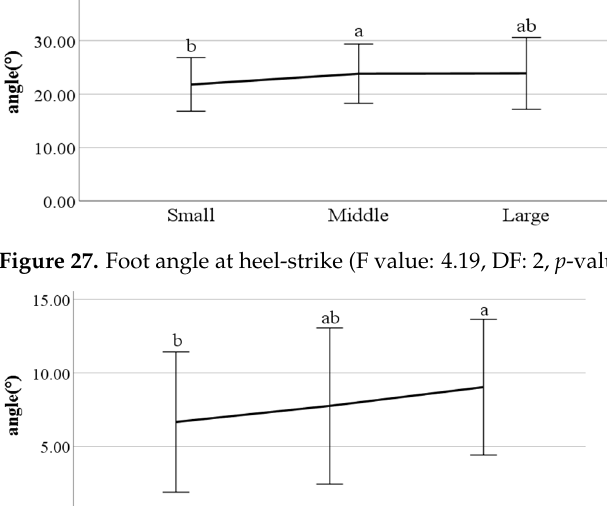
Figure 27. Foot angle at heel-strike (F value: 4.19, DF: 2, p -value: 0.02).